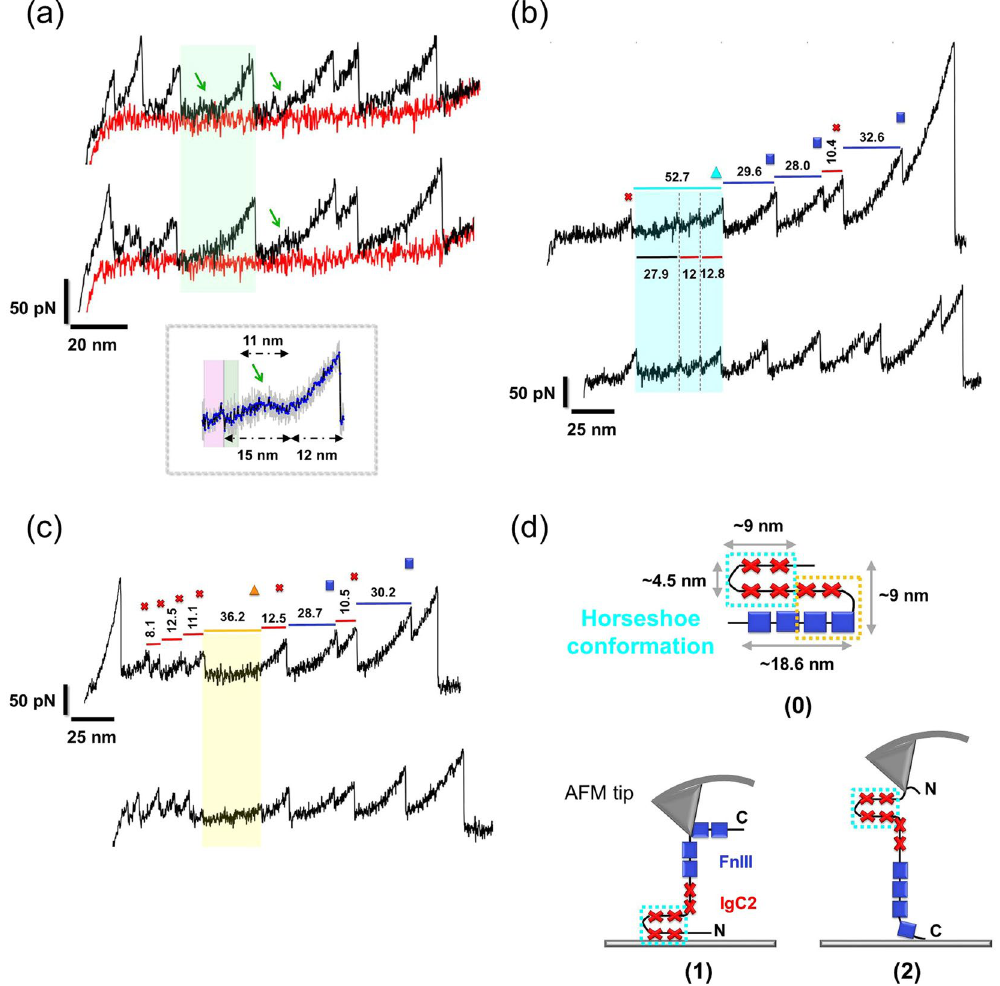
Figure 4. Force-extension curves with sawtooth patterns and characteristic of specific conformational changes observed for CNTN4 in smFS AFM. ( a ) Force-extension curves with similar unfolding scenarios. Green arrows show smoothly raising “plateau” with a clear ~13–18 nm hump, potential intermediate state in FnIII domain. Green area highlights similar unfolding event of FNIII module with (top curve) and without (bottom curve) the hump. In the inset the average of 7 similar unfolding peaks (blue curve) with standard deviation (grey) is shown. Panels ( b ) and ( c ) present long “plateaus” (blue, yellow areas) proceeded by a partial unfolding of a single ( b ) or several ( c ) Ig domains. ( d ) Hypothetical structure of adsorbed native CNTN4 with a horseshoe conformation (light-blue box) (0), possible unfolding arrangements of CNTN4 with the horseshoe fold of IgC2 1–4 modules are shown in schemes (1) and